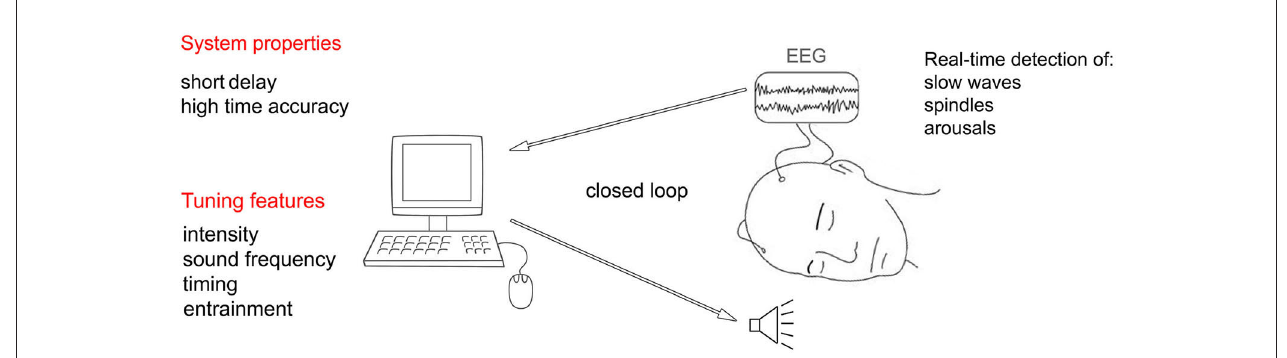
FIGURE 6 | Schematic representation of an automated real-time system capable of adjusting acoustic stimulation parameters according to the ongoing sleep